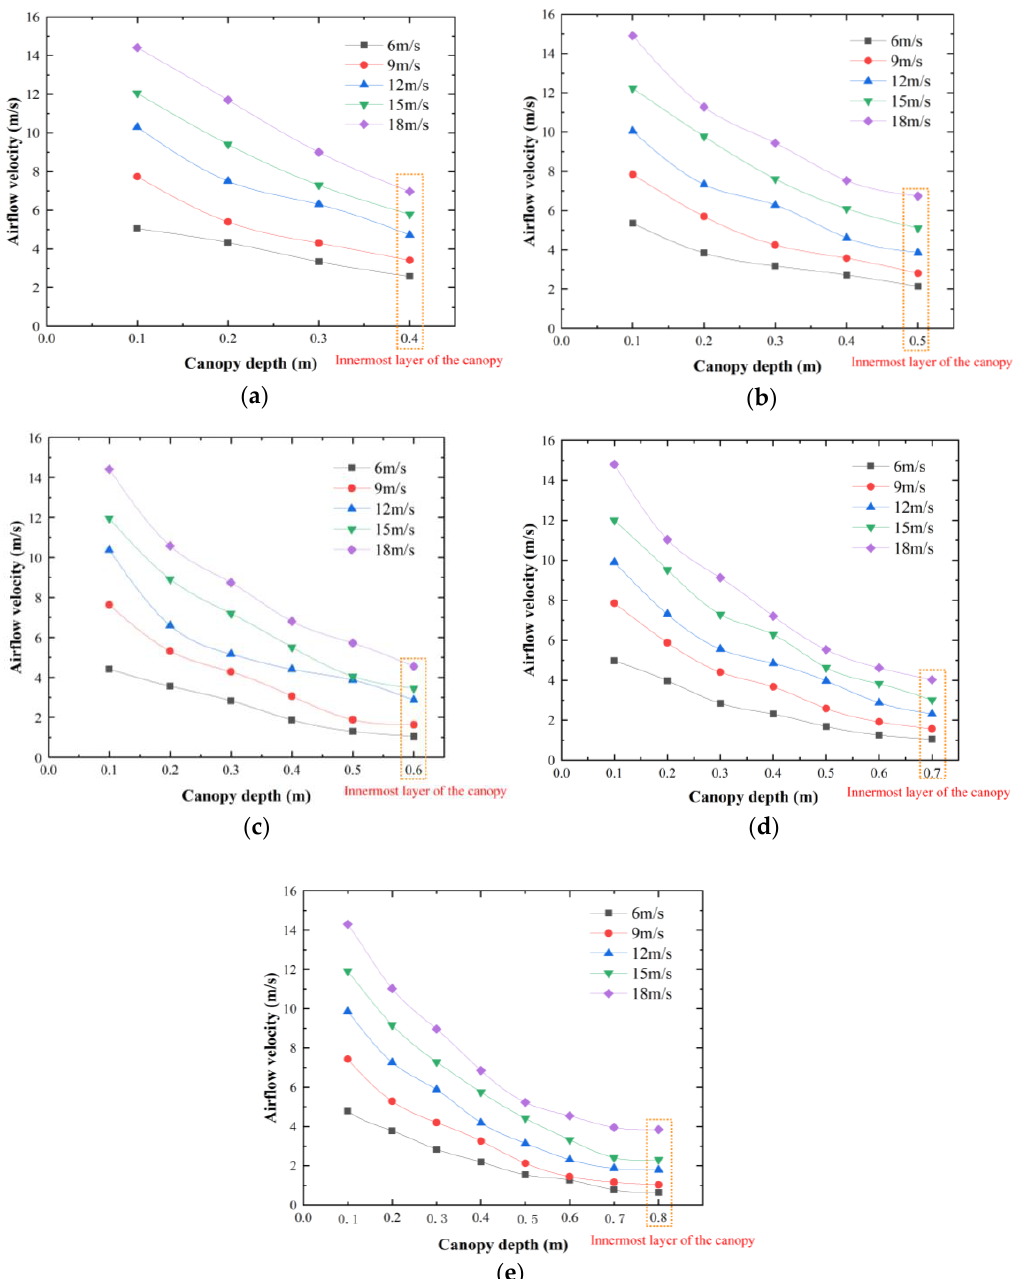
Figure 5. Variation in airflow attenuation within the canopy of pear trees of different crown diameters. ( a ) Crown diameter 0.8 m. ( b ) Crown diameter 1.0 m. ( c ) Crown diameter 1.2 m. ( d ) Crown diameter 1.4 m. ( e ) Crown diameter 1.6 m.